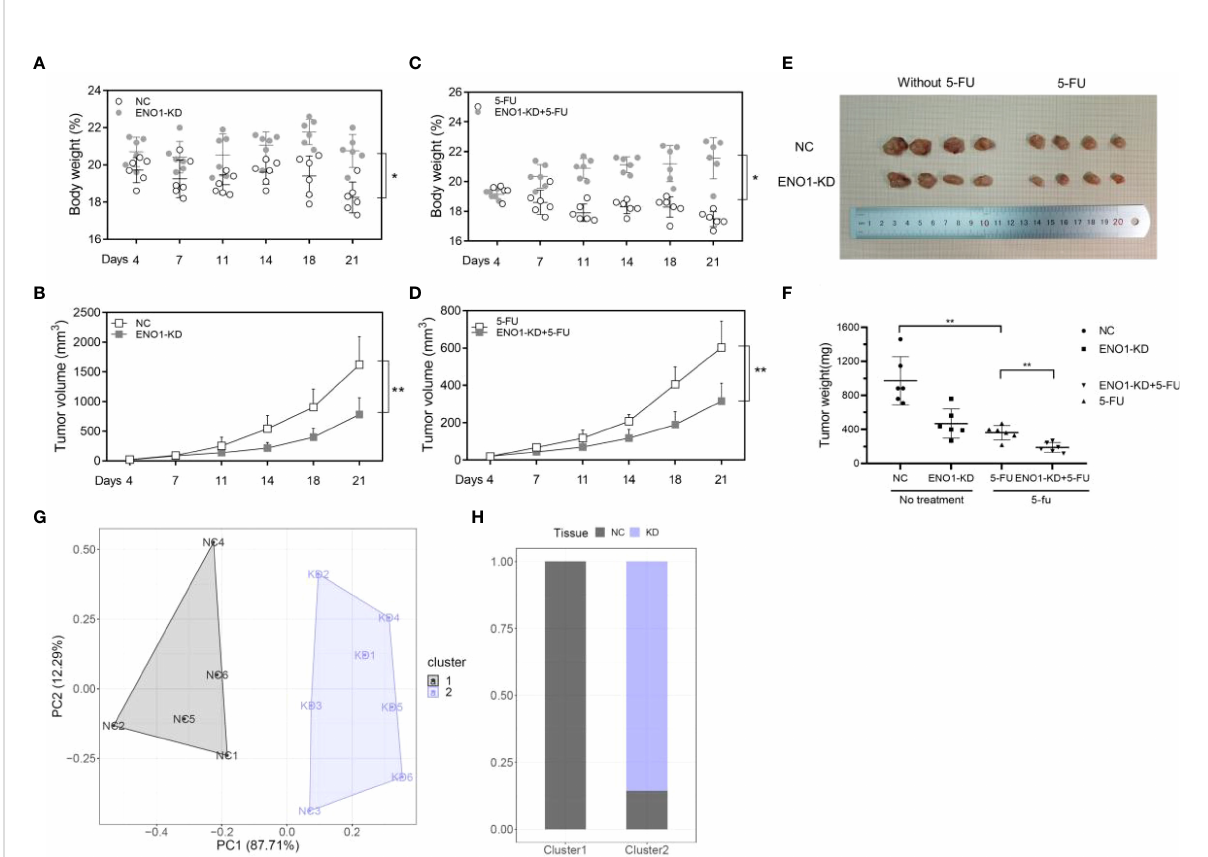
FIGURE 7 ENO1 knockdown suppresses tumor growth in colorectal cancer (CRC) in vivo . (A, B) Total body weight and tumor volume in ENO1-KD and NC groups. (C, D) Total body weight and tumor volume in ENO1-KD+5-FU and 5-FU groups. (E) Representative pictures of subcutaneous tumors harvested from the four groups. (F) The weights of tumor masses with or without treatment. (G) Strati fi cation of mice into cluster 1 (grey) and cluster 2 (blue) according to tumor weight and ENO1 levels. (H) Percentage of NC and ENO1-KD mice in each cluster. Statistical analyses were performed via two-tailed Student t test. *, P ≤ 0.05; **, P ≤